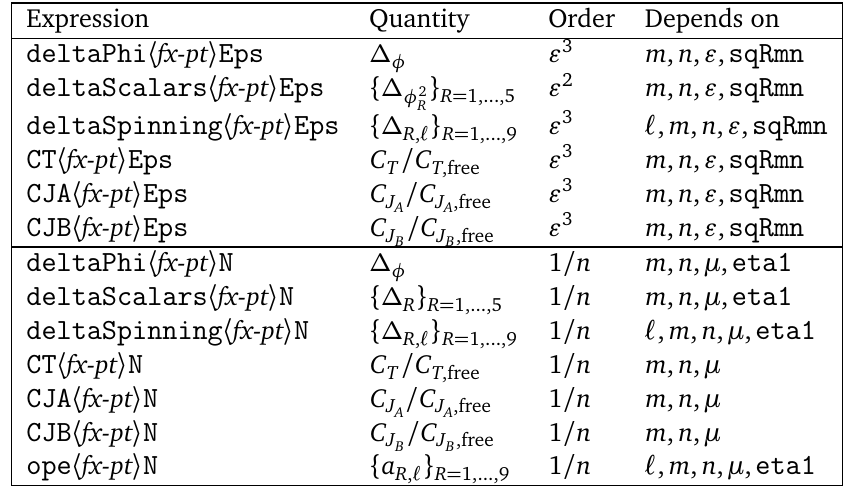
Table 6: Quantities given in the ancillary data